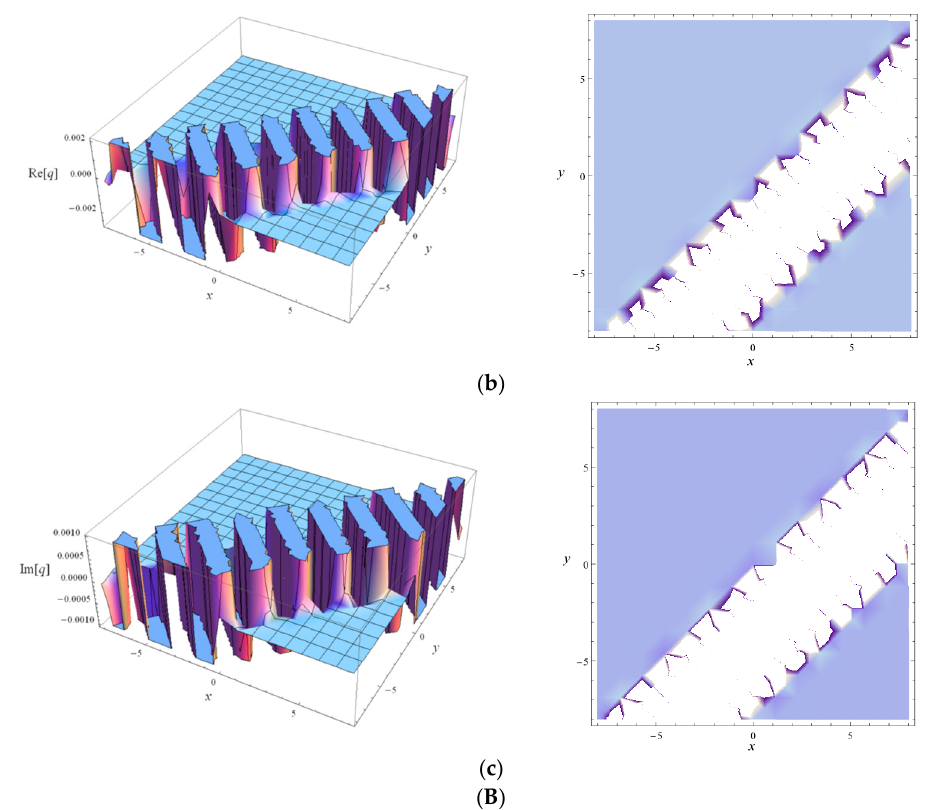
= t . ( A ) The performance of ( ) tyxq ,, . ( Ba )